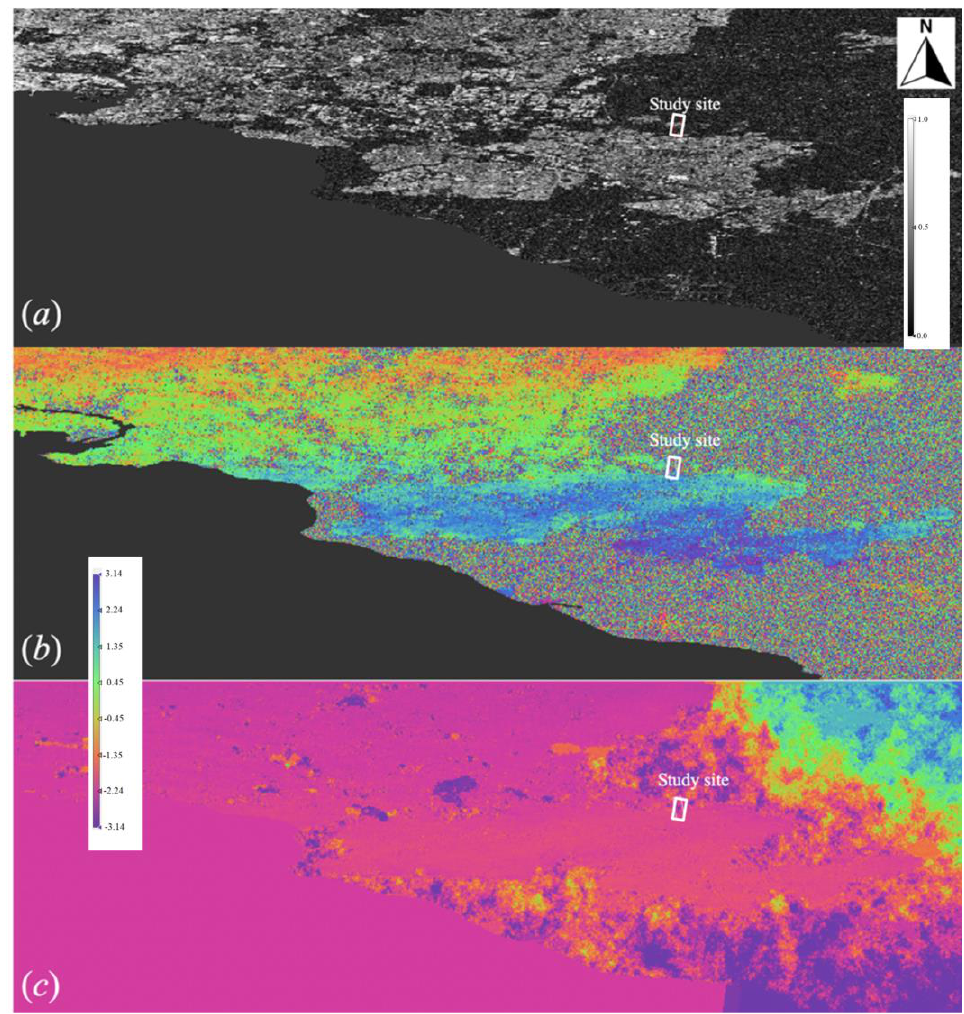
Figure 8. Results of ( a ) coherence, ( b ) wrapped phase, and ( c ) unwrapped phase.